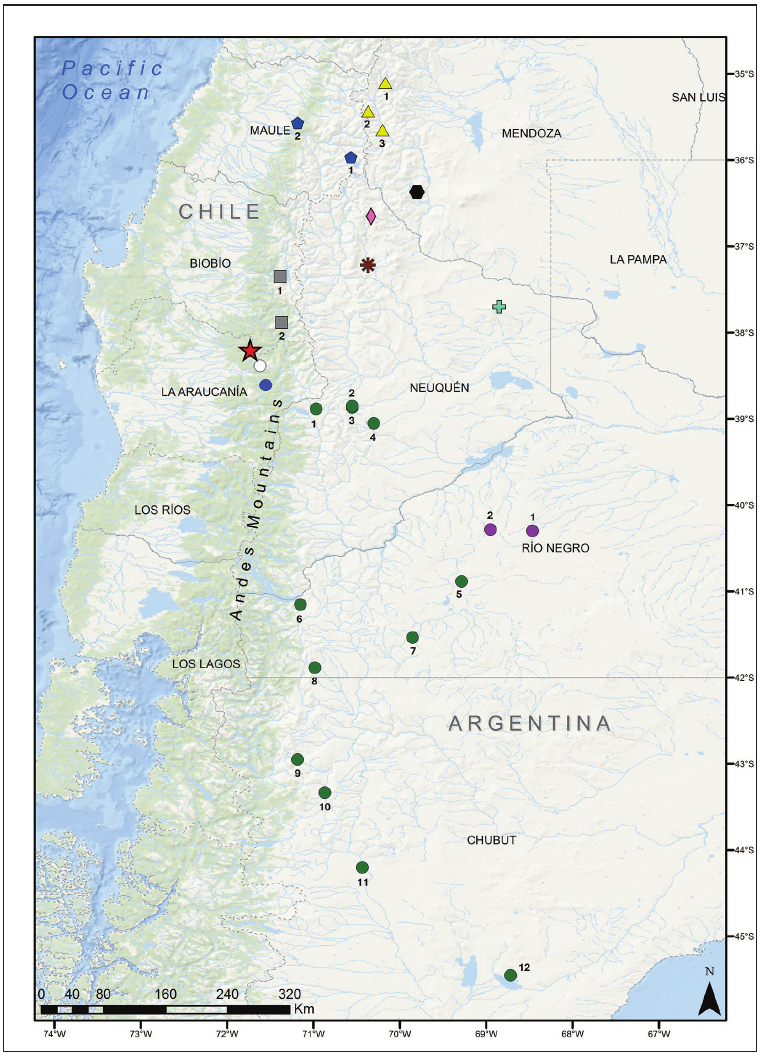
Figure 5. Distribution map for Liolaemus janequeoae sp. n. with geographically proximate species of the L. elongatus clade. In the case of L. elongatus a sample for each locality was included in the phylogeny. Red star: L. janequeoae sp. n., Laguna Verde. Yellow triangles: L. smaug (1= near Las Leñas, 2= between Las Loicas and Peteroa Volcano, 3= near Las Loicas). Blue pentagon: L. carlosgarini (1= Maule Lagoon, 2= Lircay). Black hexagon: L. choique (Paso el Choique). Pink diamond: L. antumalguen (Domuyo Vol- cano). Brown asterisk: L. burmeisteri (Caepe Malal). Green cross: L. crandalli (Auca Mahuida Volcano). Gray squares: L. scorialis (1= Laja Lagoon, 2= La Mula Lagoon). White circle: L. lonquimayensis (Lon- quimay Volcano). Pink circles: L. shitan (1= Estancia Piedras Blancas, type locality and 2= near Antonio del Cuy). Blue circle: L. cf. elongatus (Llaima Volcano). Green circles: L. elongatus (1= Pampa de Lonco Luan, 2= Primeros Pinos, 3= Portal La Atravesada, 4= Laguna Blanca, 5= near Ingeniero Jacobacci, 6= San Carlos de Bariloche, 7= Ojo de Agua, 8= El Maiten, 9= Esquel, 10= Tecka, 11= Gobernador Costa and 12= Los